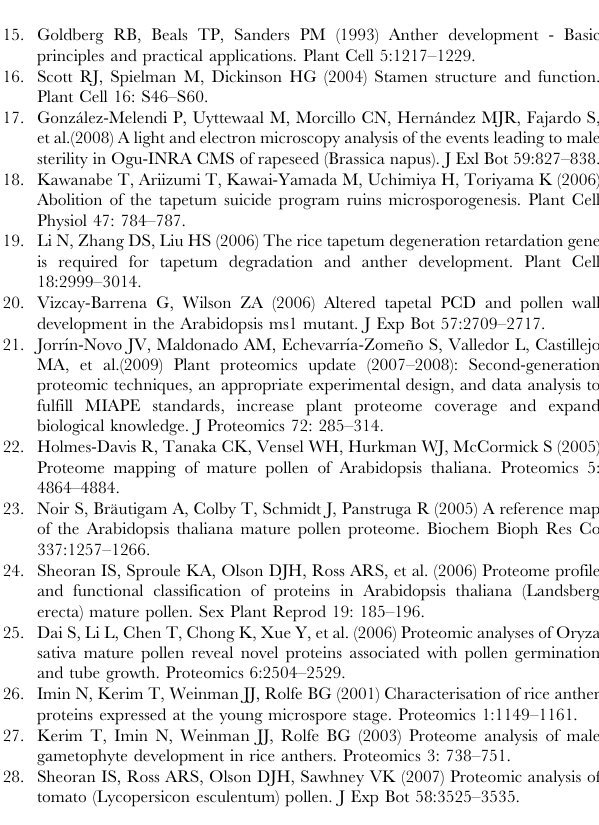
Figure S2 Representative 2-DE gels of proteins in leaves, small buds, anthers from medium buds and anthers from large buds of control and MES-treated plants. Total proteins were extracted by the TCA–acetone precipitation method and separated by IEF/SDS-PAGE. Proteins